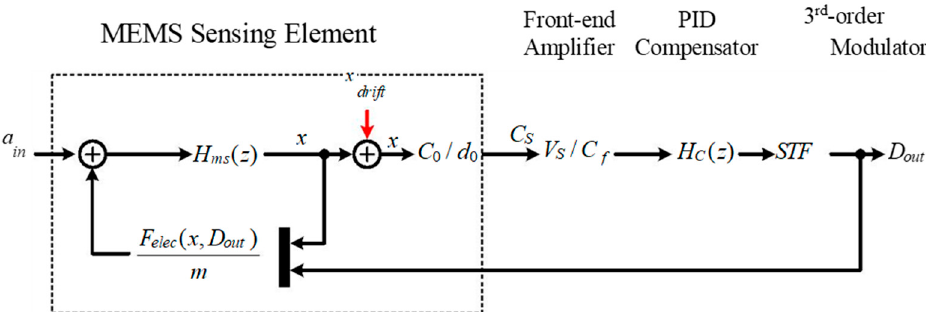
Figure 3. The small signal flow diagram of the whole system.